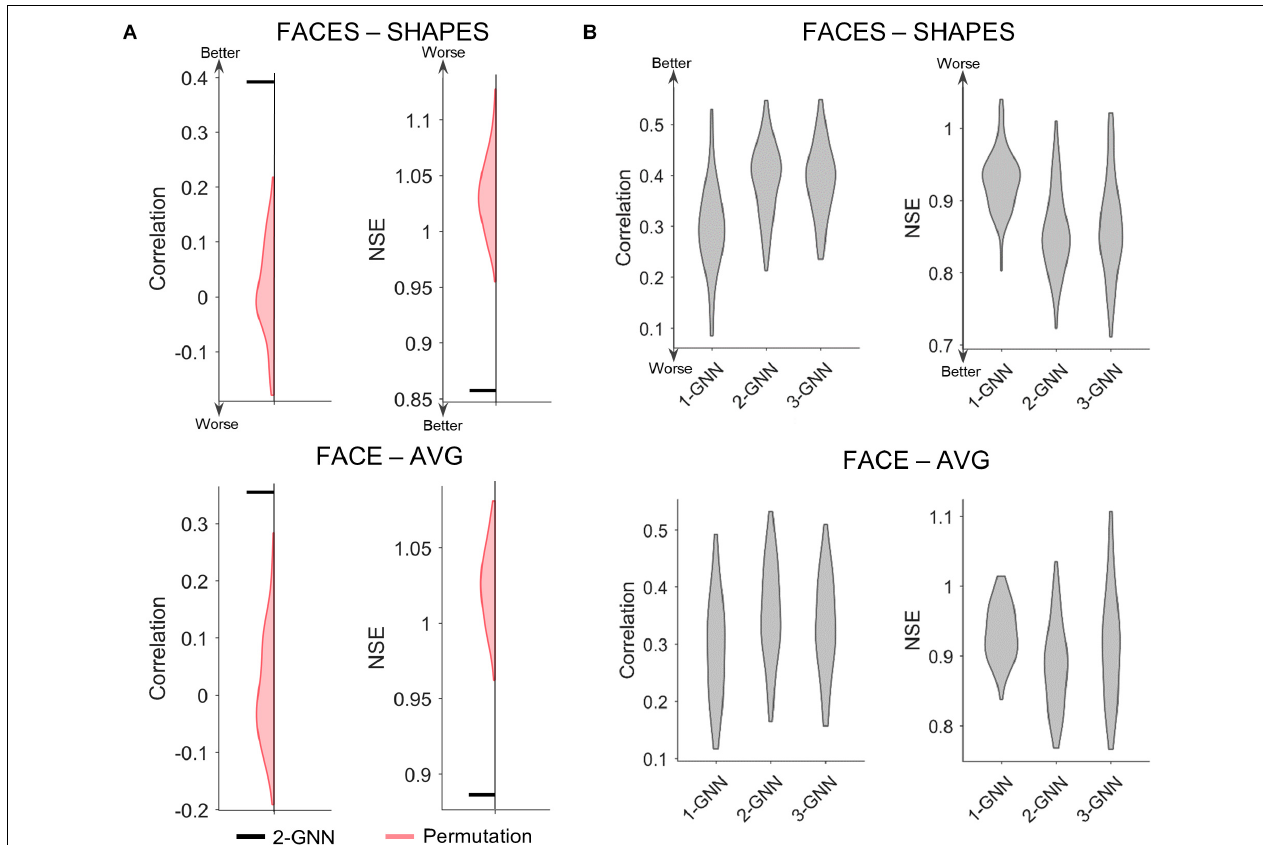
FIGURE 3 | Comparison of prediction metrics for different models. (A) Comparison between the two-layer graph neural network (2-GNN) and the random permutation model with the same structure. The prediction performance of 2-GNN is better than that of random permutation model in that the mean NSE of 2-GNN is below the distribution of permutation and the mean correlation of 2-GNN is above the distribution of permutation. (B) Comparison of graph neural networks with different layers. The 2-GNN has a higher ability to predict better individual differences than both the 1-GNN and 3-GNN.